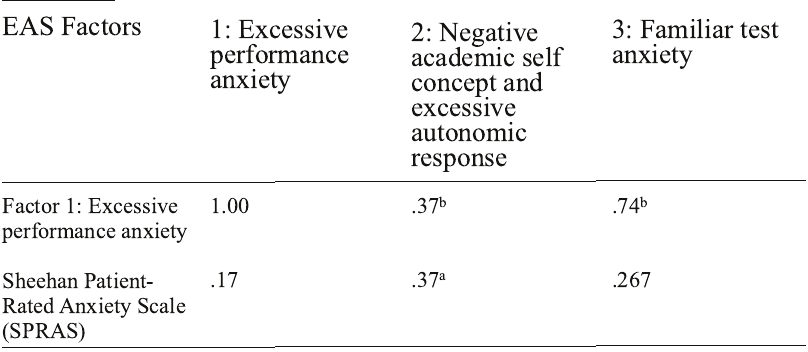
Note. a Correlation is significant at the 0.05 level (2-tailed). b Correlation is significant at the 0.01 level